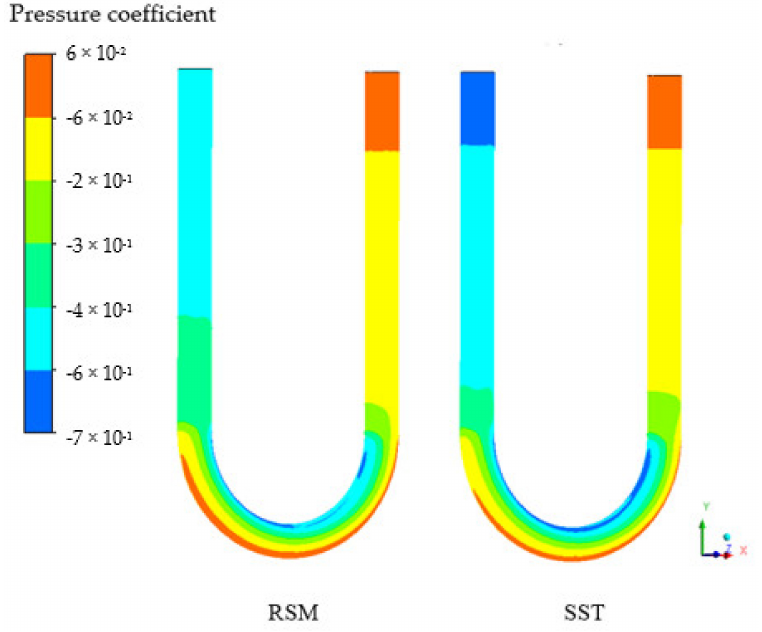
Figure 12. The pressure coefficient for the shear stress (SST) and Reynolds stress (RSM) turbulence models for the Case D at 8 m/s.